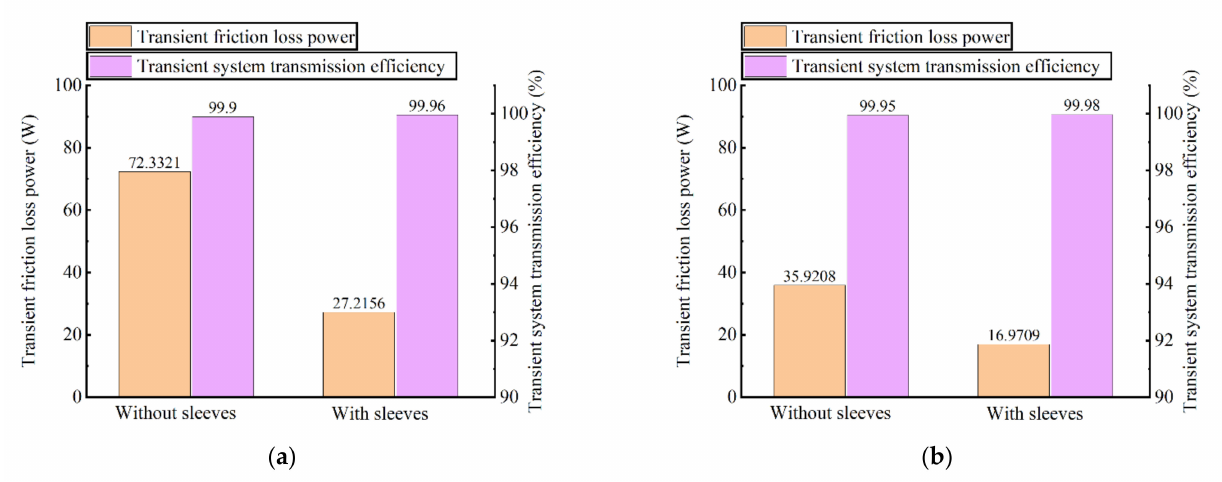
Figure 13. Average efficiency and average power comparison. ( a ) t = 0 ms; ( b ) t = 10